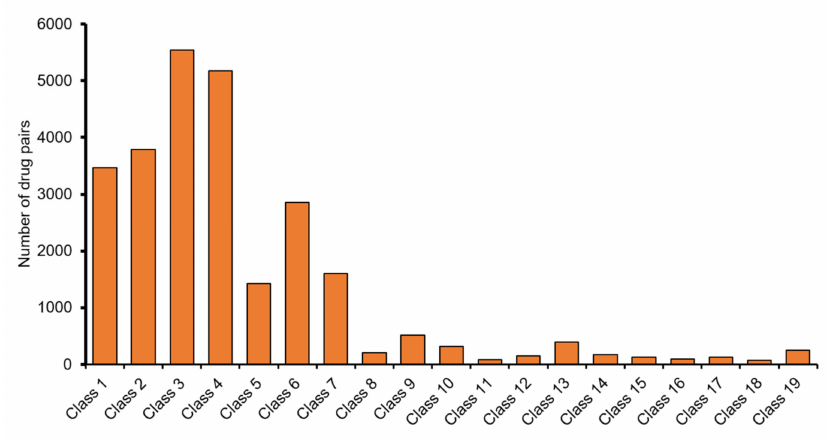
Figure 2. The number of drug pairs of 19 DDI types (classes) after cut-off low data classes.